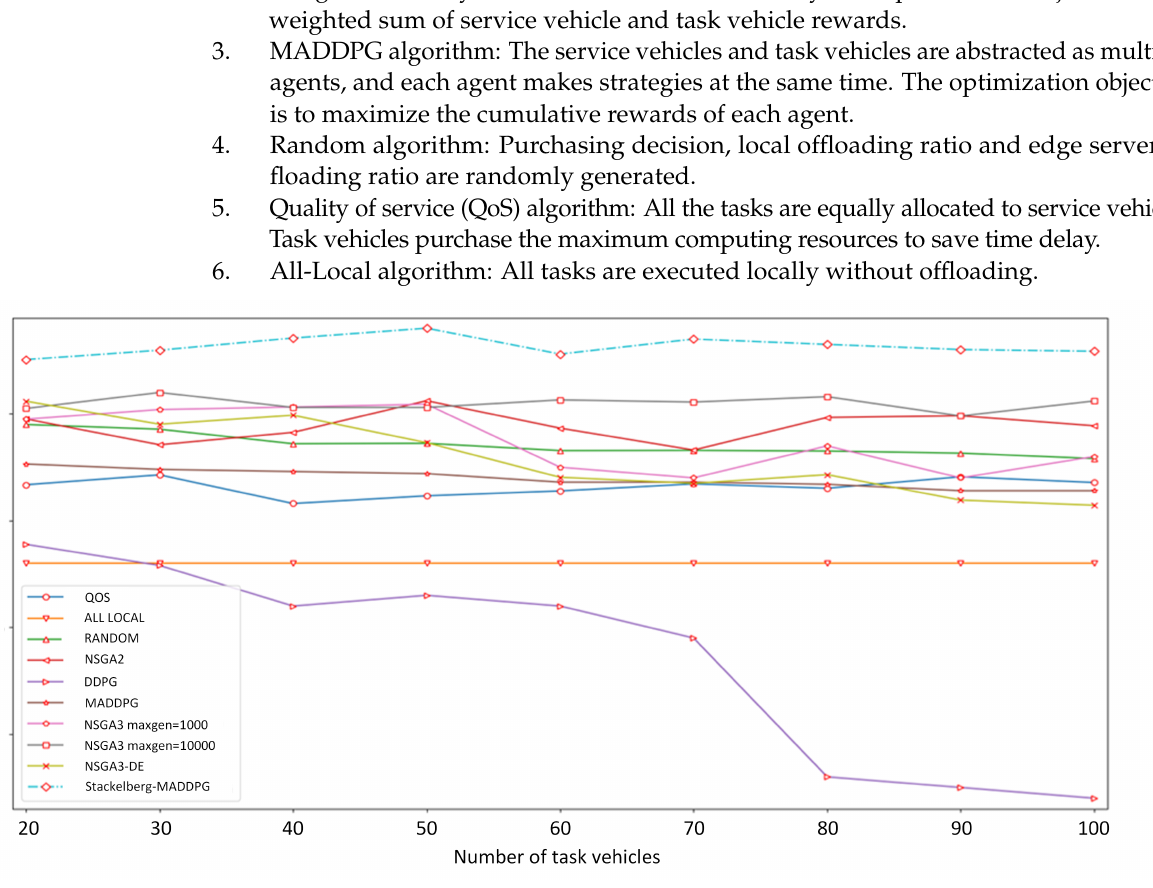
Figure 8. Average utility curve of task vehicles with different